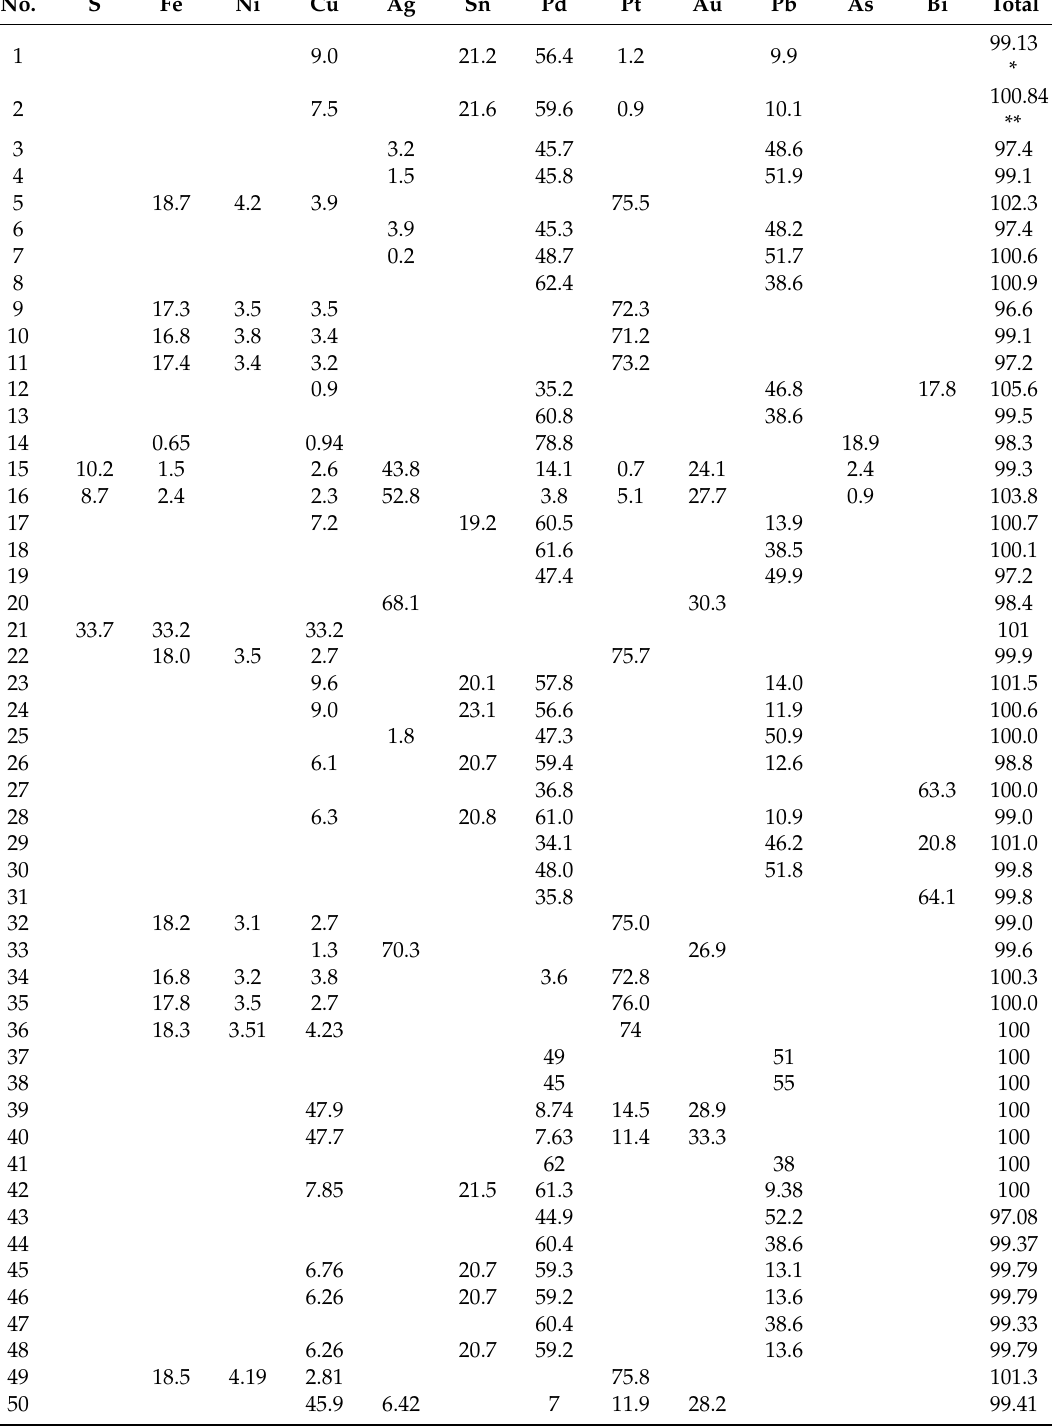
Table 11. Chemical composition of platinum group minerals, wt